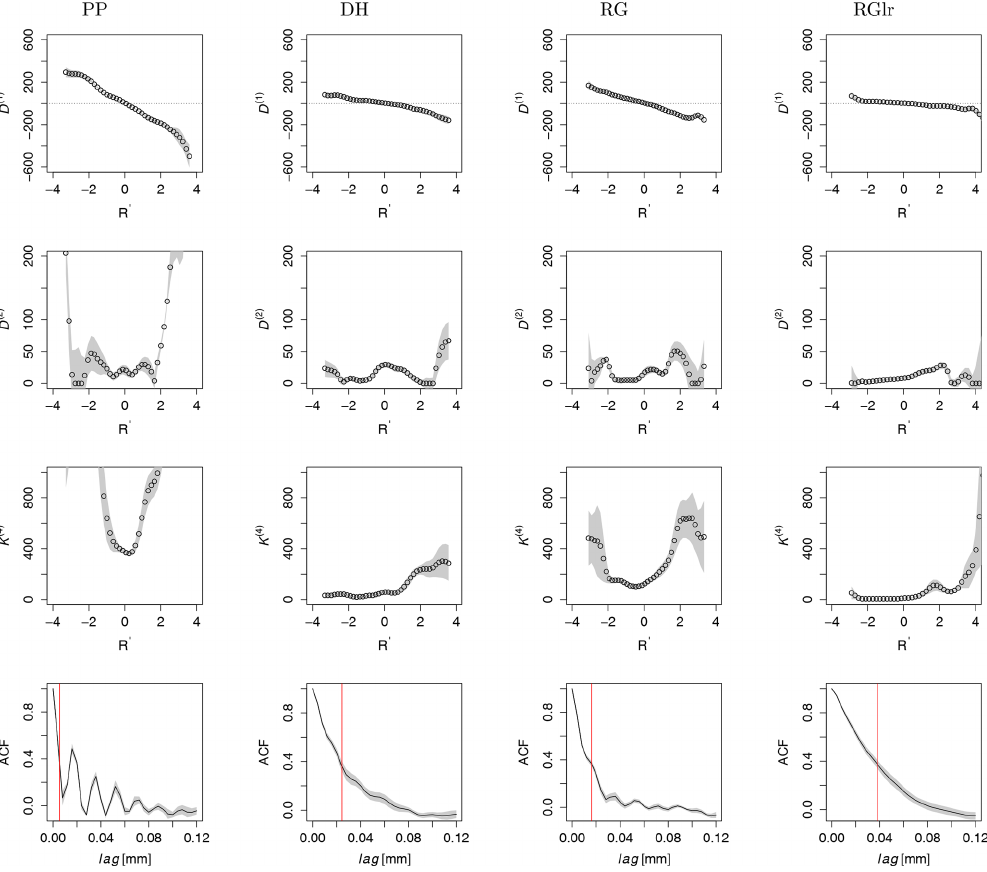
Figure 8. State-dependent drift D ( 1 ) (R (cid:48) ) , diffusion D ( 2 ) (R (cid:48) ) , fourth-order KM coefficients K ( 4 ) (R (cid:48) ) and their respective autocorrelation functions (ACFs) of four different snow types, PP, DH, RG and RGlr (left to right). The errors are shown as gray-shaded background. The red lines in the ACF plots indicate the correlation length scales determined from ACFs. Comparing the correlation length scales L C = 1 D ( 1 ) = − γR (cid:48) with those of the autocorrelation functions (ACFs), we find that both length scales have the same ordering of their values for all snow